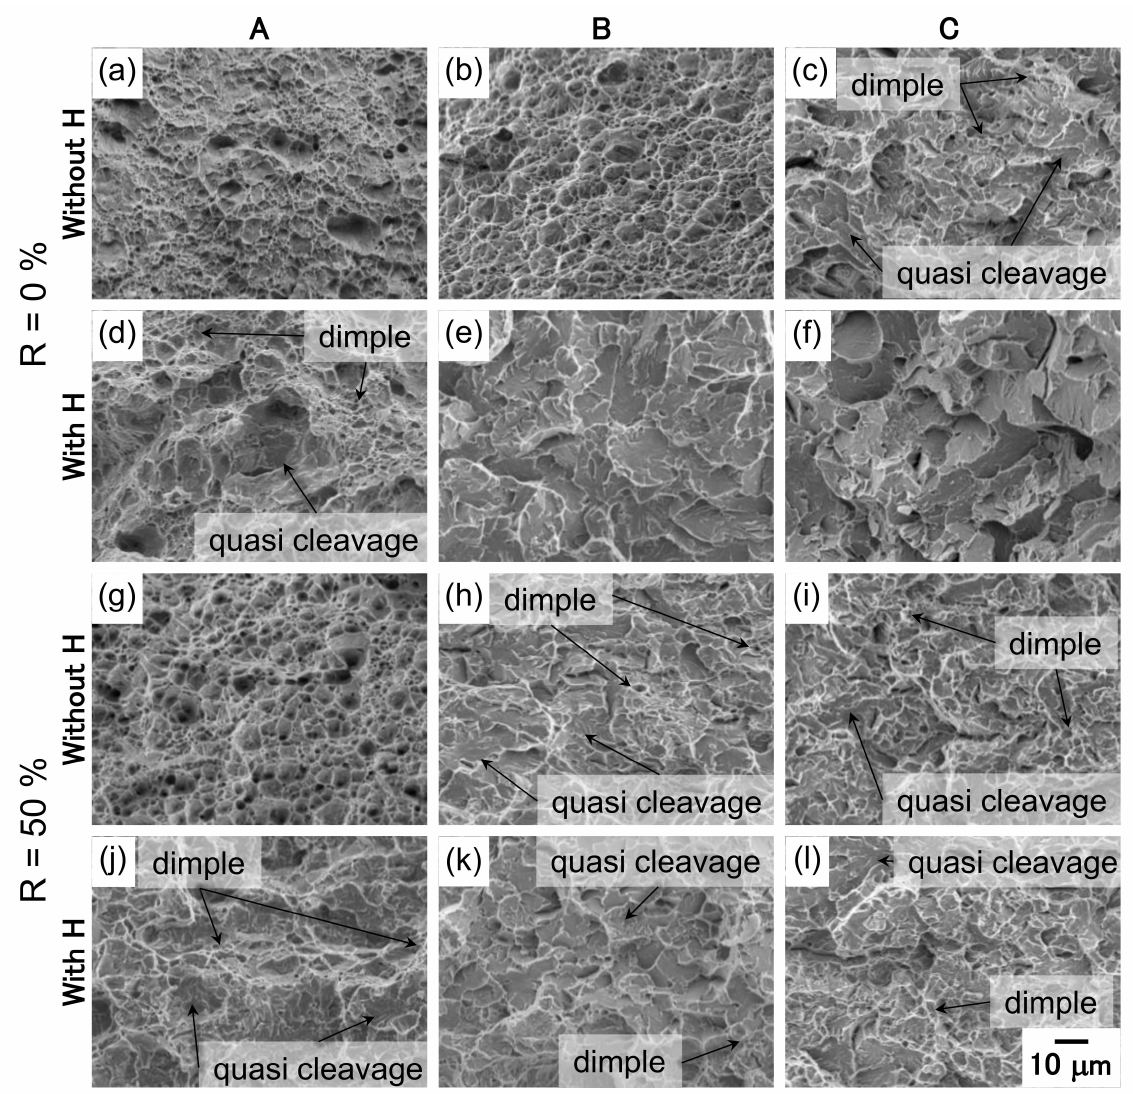
Figure 5. Fracture surfaces of ( a – f ) conventional and ( g – l ) hot-forged steels ( a , d , g , j ) A, ( b , e , h , k ) B, and ( c , f , i , l ) C ( d - f , j - l )with and ( a – c , g - i ) without hydrogen after tensile tests. R represents reduction